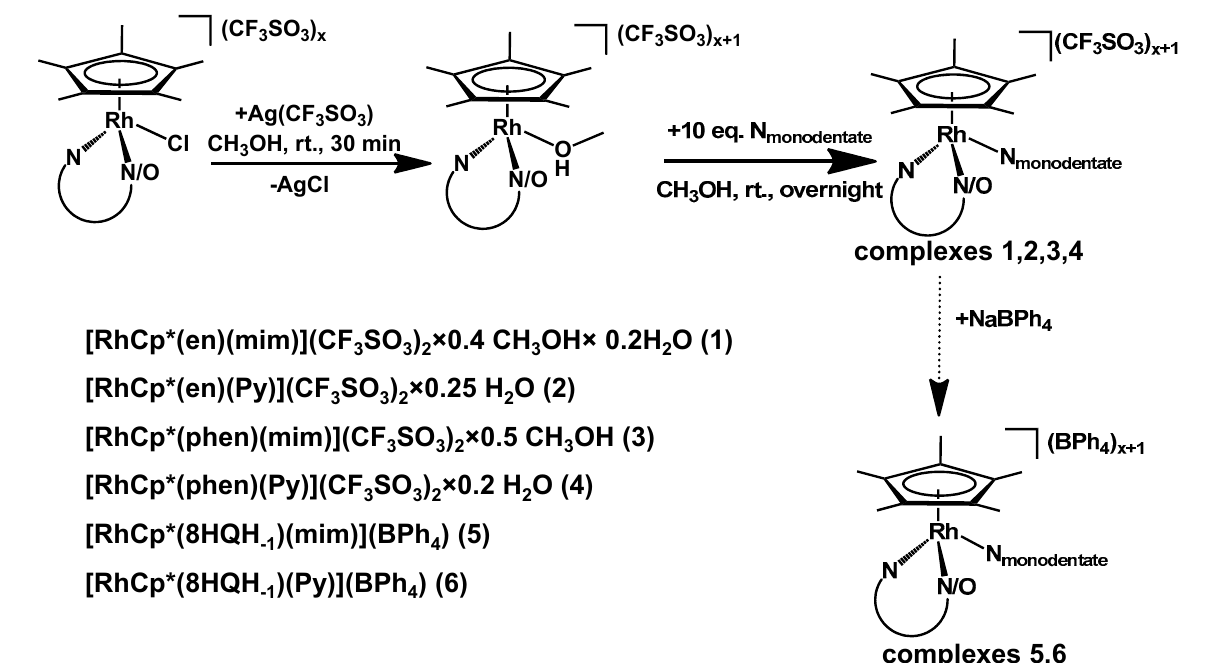
Scheme 1. Synthetic steps for the preparation of the mixed ‐ ligand half ‐ sandwich RhCp* com ‐